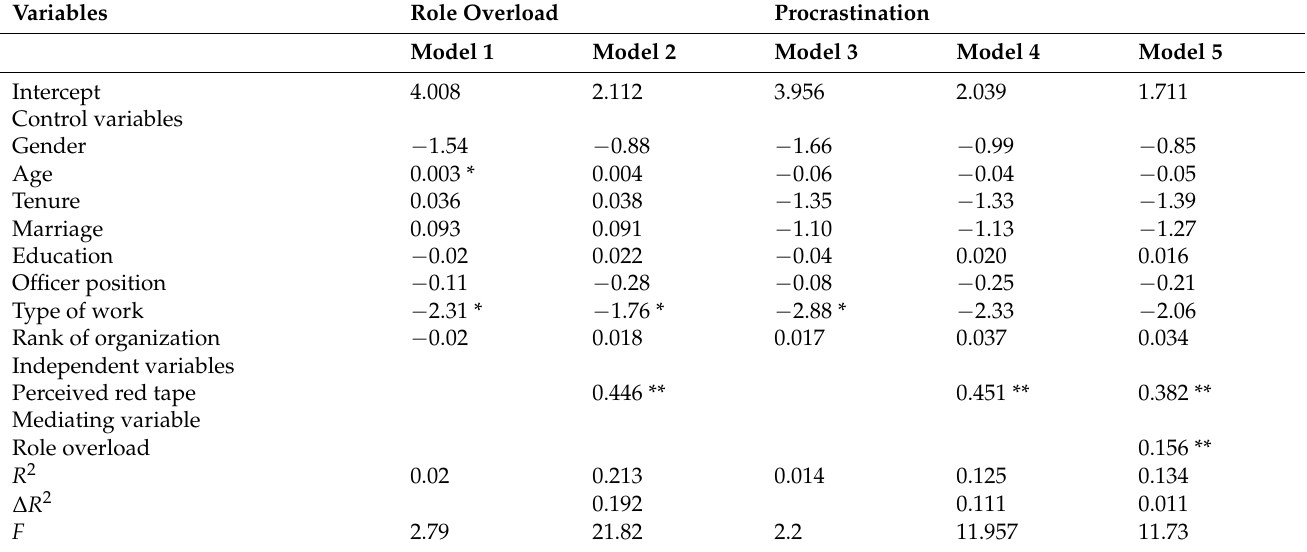
Table 3. Result of main effects and mediation